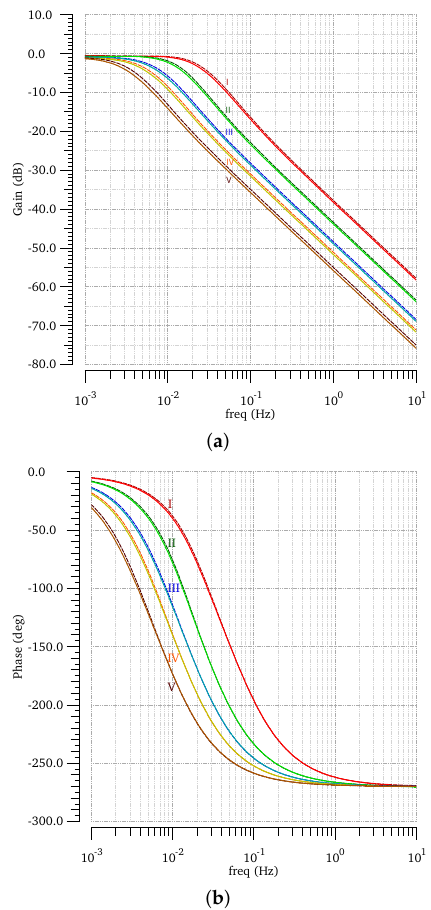
Figure 19. Post-layout simulation results showing the ( a ) gain and ( b ) phase responses of the closed- loop plant.